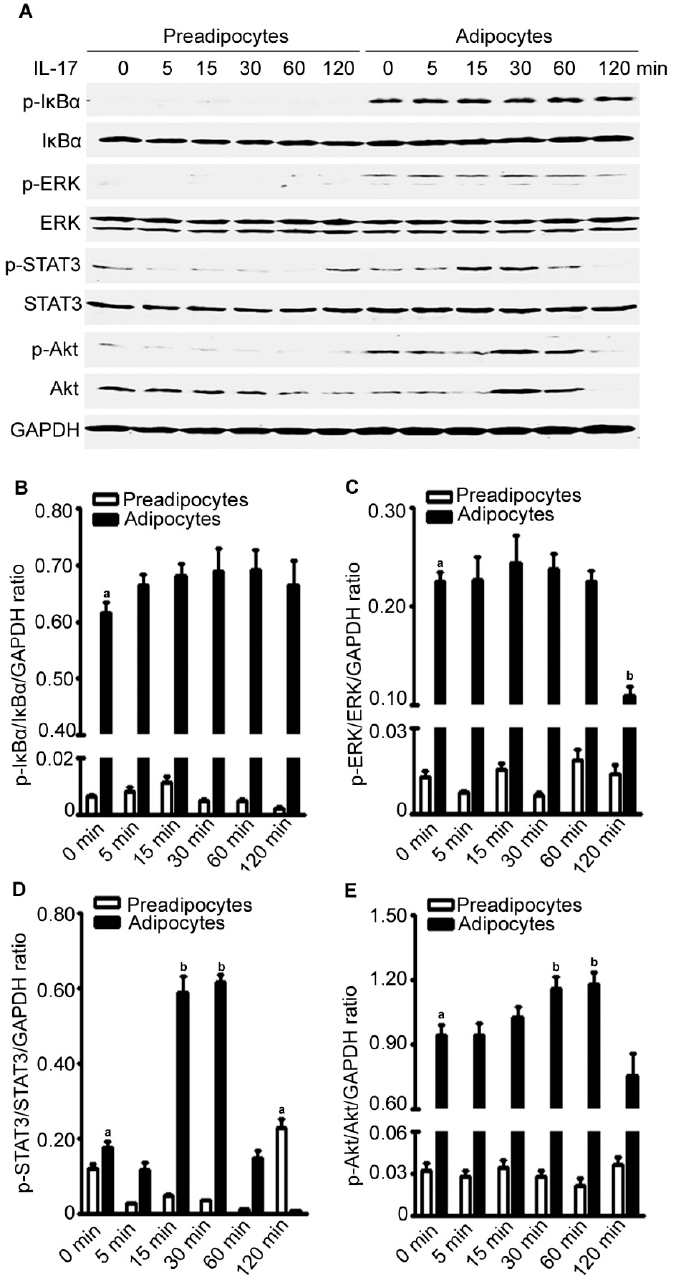
Figure 8. IL-17A differentially activates signaling pathways in pre-adipocytes and adipocytes. ( A ) The pre-adipocytes and adipocytes were treated without (time zero) or with 20 ng/mL IL-17A for 5, 15, 30, 60, and 120 min; proteins were assessed by Western blot analysis; GAPDH was probed for loading control; ( B – E ) quantification of the Western blot results in ( A ); data are mean ± standard error of the mean (SEM) of three independent experiments; a p < 0.05, compared to the untreated group of the pre-adipocytes; b p < 0.05, compared to the untreated group of the adipocytes.